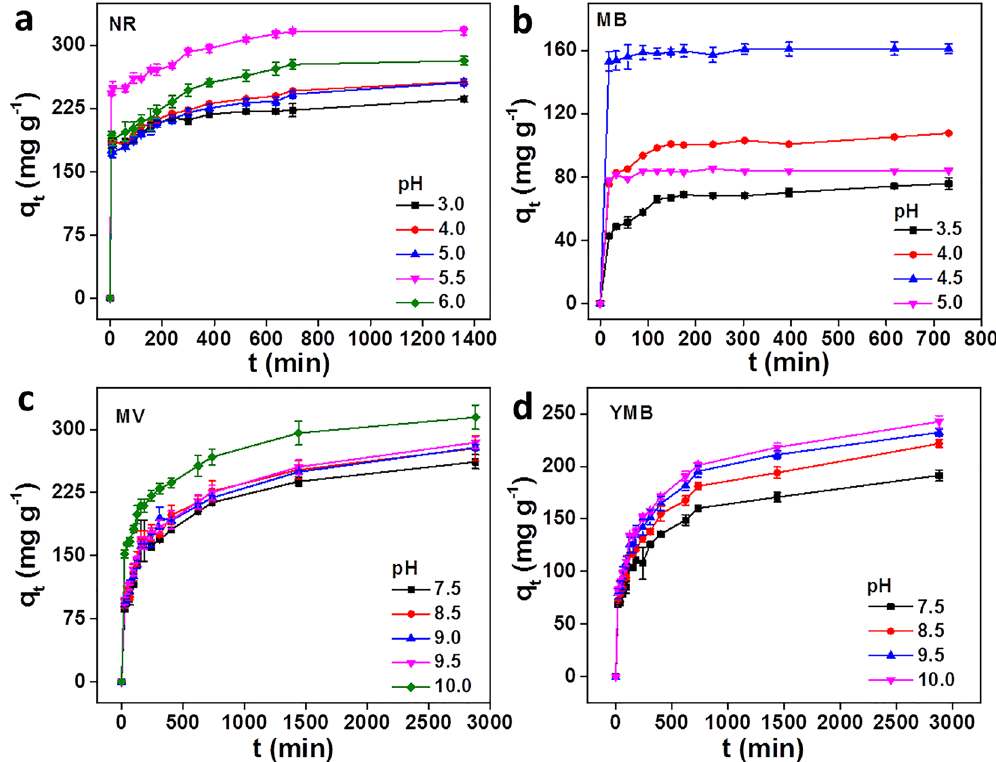
Figure 1. The effect of pH value on the adsorption of PAAM/PA/PDA hydrogel to ( a ) NR, ( b ) MB, ( c ) MV and ( d ) YMB,